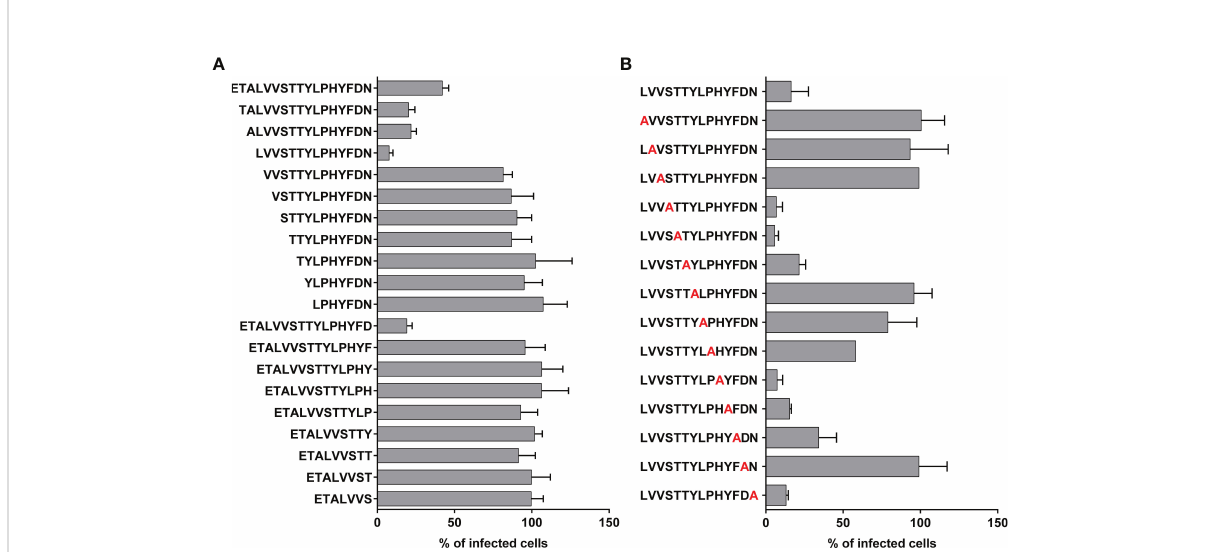
FIGURE 2 Antiviral activity of truncated and alanine mutated peptides. (A) Peptide derived from the CDR3 region of D25 antibody was truncated from C- and N-terminus and the antiviral activities of the truncated peptides were compared in RSV inhibition assay. (B) Truncated peptide with the highest antiviral activity underwent alanine-scanning mutagenesis and the mutated peptides were tested in RSV inhibition assay. For the test of the antiviral activity in A and B, 20 µM of peptides were mixed with 150 FFU of rgRSV and the mixtures were applied to HEp-2 cell monolayers that were seeded the previous day. As a control, cells received virus and treatment with vehicle (DMSO in PBS). Infected cells were analyzed at 2 dpi using fl uorescence EliSpot reader and presented as % of FFU numbers in treated/sham-treated samples. Shown are mean values of two independent experiments, each in triplicates ±